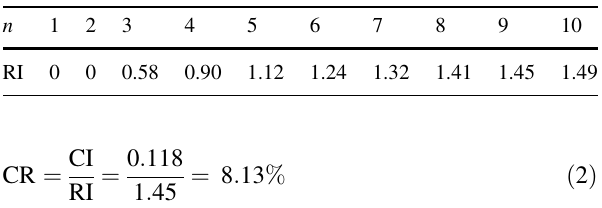
Table 5 Random consistency index proposed by Saaty. Source :